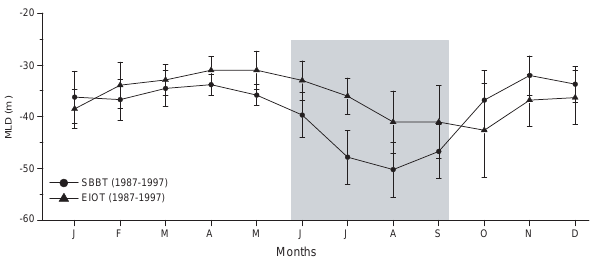
Fig. 6. Monthly mean climatology (1987–1997) of ECMWF wind speed (ms − 1 ) at SBBT (filled circle) and EIOT (filled triangle). Shading represents the summer monsoon period (June–September) and vertical lines are one standard deviation.